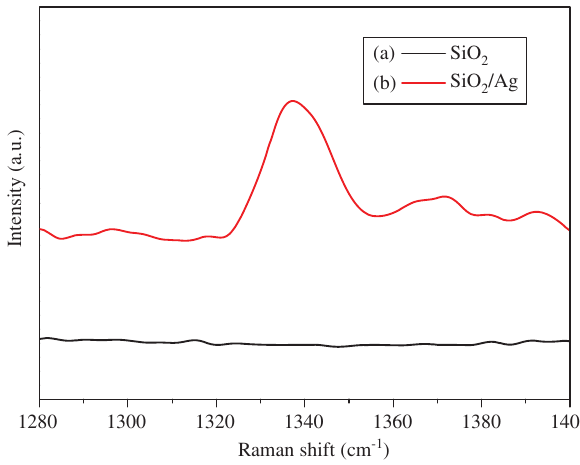
powder; (b) with 2